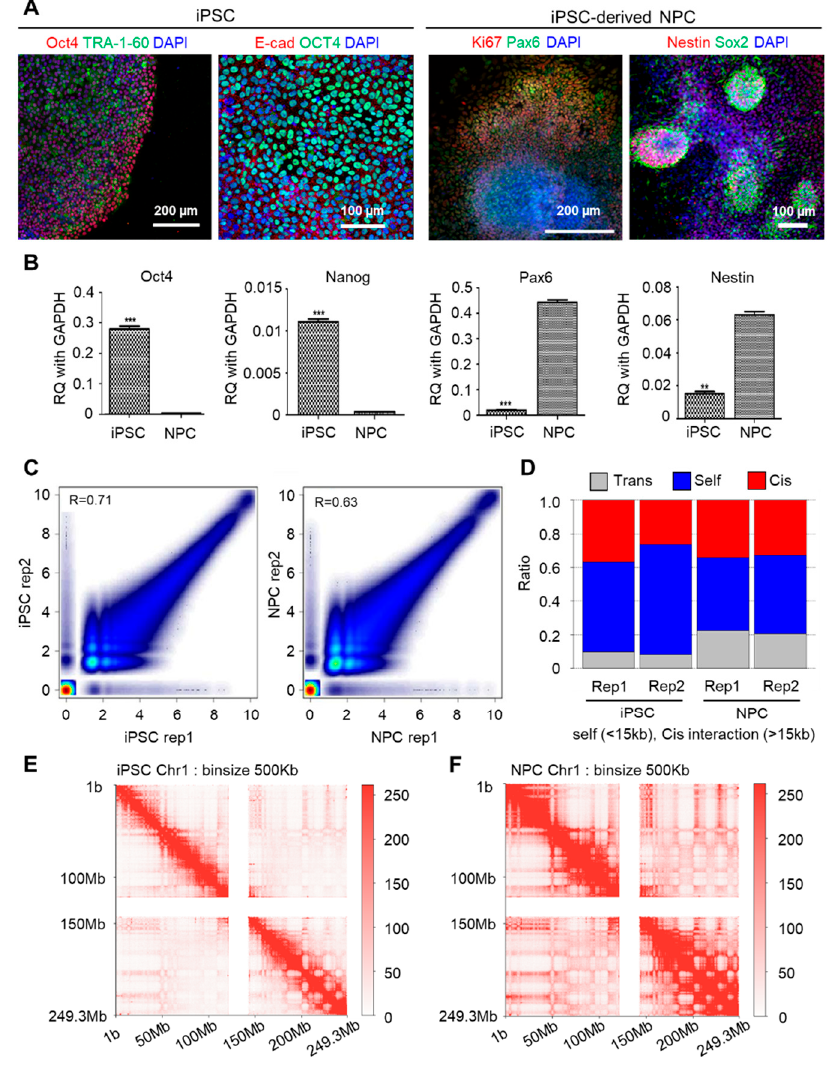
Figure 1. Genome-level interaction patterns observed using validated data. ( A ) Immunostaining of markers of iPSC (Tra-1-60, OCT4, E-Cadherin) and NPC (Nestin, Pax6, Ki67, Sox2). Scale bar is μ m. ( B ) RT-qPCR markers for stem cell pluripotency markers and NPC markers. These data include the minimum 3 replicates. Relative quantification values were normalized by GAPDH. *** refers to p -value < 0.001 and ** refers to p -value < 0.01 (unpaired two tailed t -test). ( C ) Scatter plots showing the correlation of contact counts (Pearson correlation coefficient) between 2 biological replicates of iPSC and NPC, respectively. ( D ) Consistent cis/trans interaction ratio reflect accuracy of generated libraries and pre-processing. ( E–F ) Increase in intrachromosomal interactions during neuronal differentiation reflected in a contact matrix of a representative chromosome (chr1).